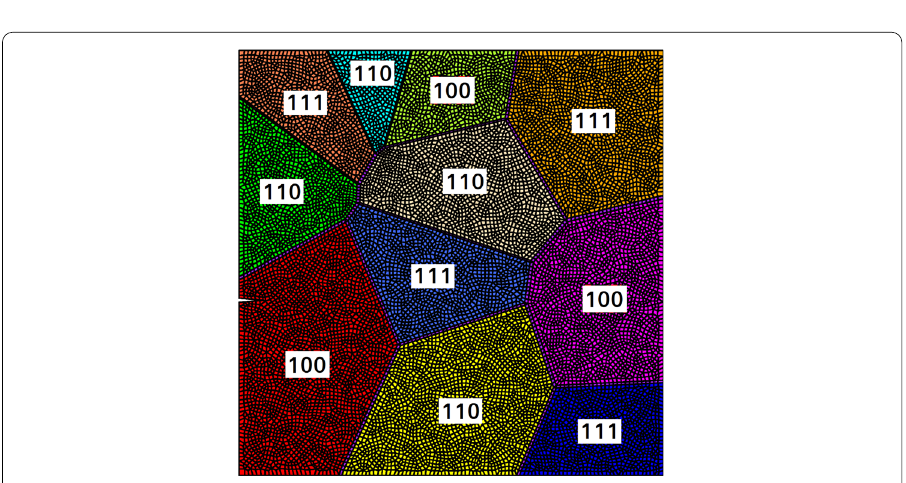
Fig. 10 Finite element mesh of the polycrystalline silicon photovoltaic cell. The specimen has a notch on the left edge. The grain orientations are specified by the Miller indices in the grains and by the different colours (from [51])